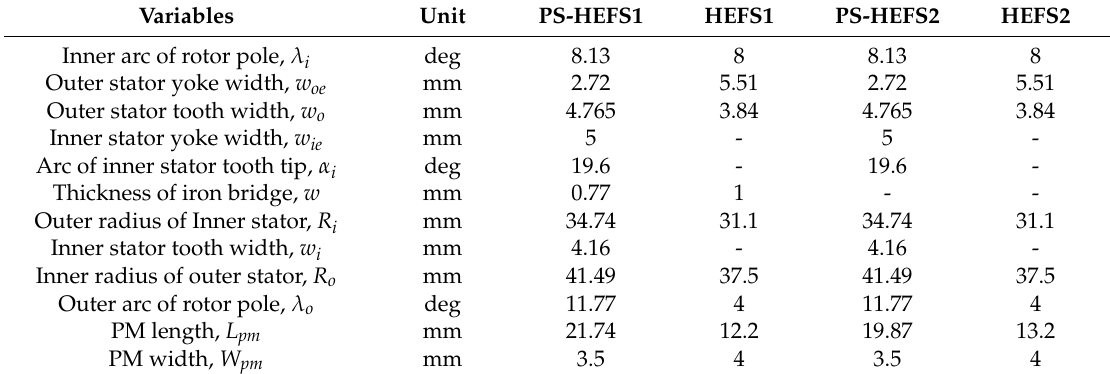
Figure 7. Sensitivity analysis for design objectives. Table 2. Initial values of design variables Table 2. Initial values of design variables